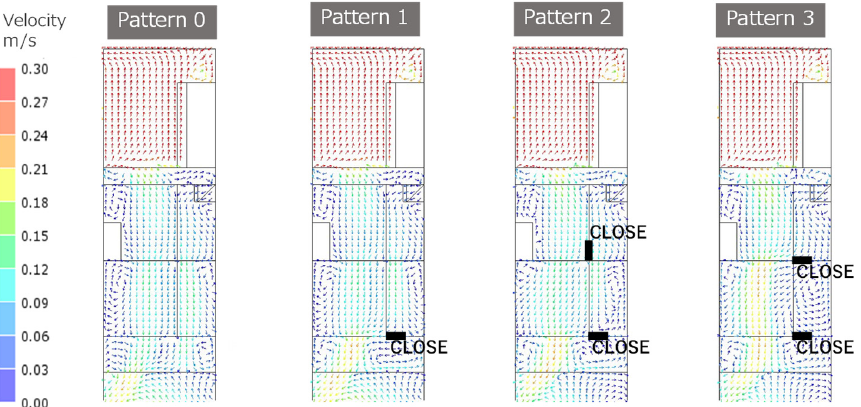
Figure 15. Simulated results of airflow patterns and velocities.